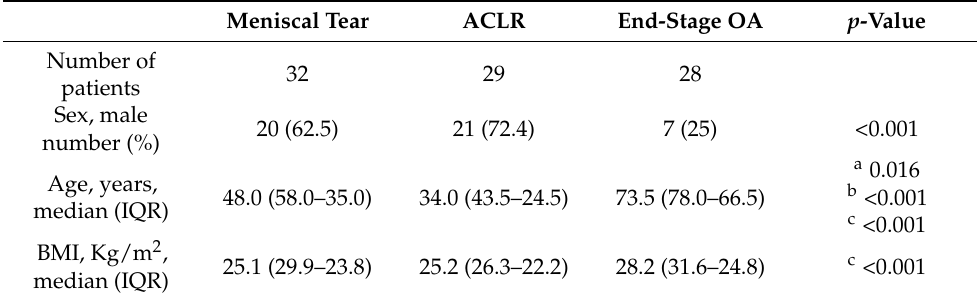
Table 1. Demographic data of enrolled